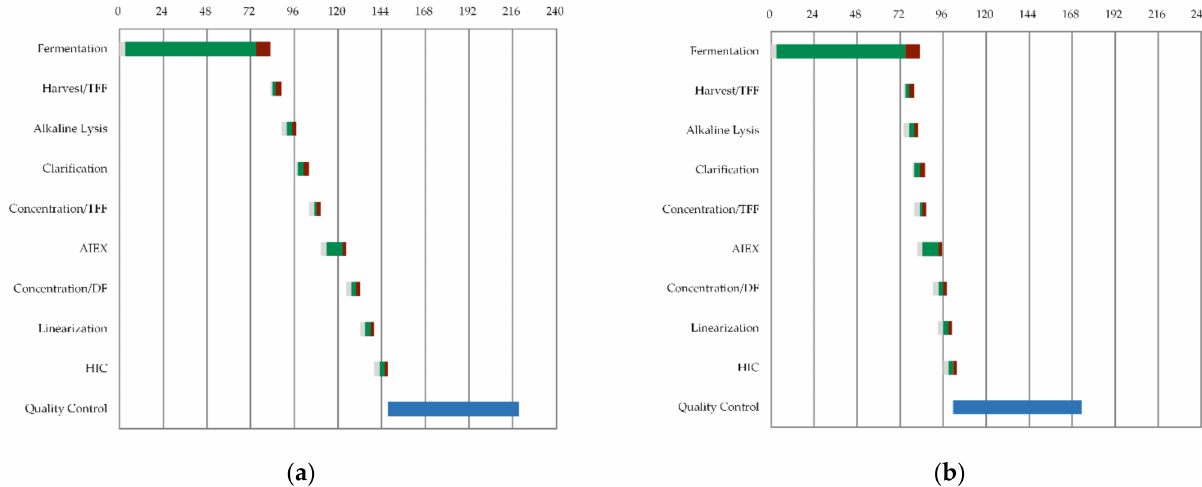
Figure 3. Batch pDNA production schedule. Scheduled with downtime between unit-operations due to preparation and CIP/SIP procedures ( a ) and with no processing downtime ( b ). Preparation (gray); Processing (green); CIP/SIP (dark red); Quality control (blue). Numbers on the x -axis represent hours.